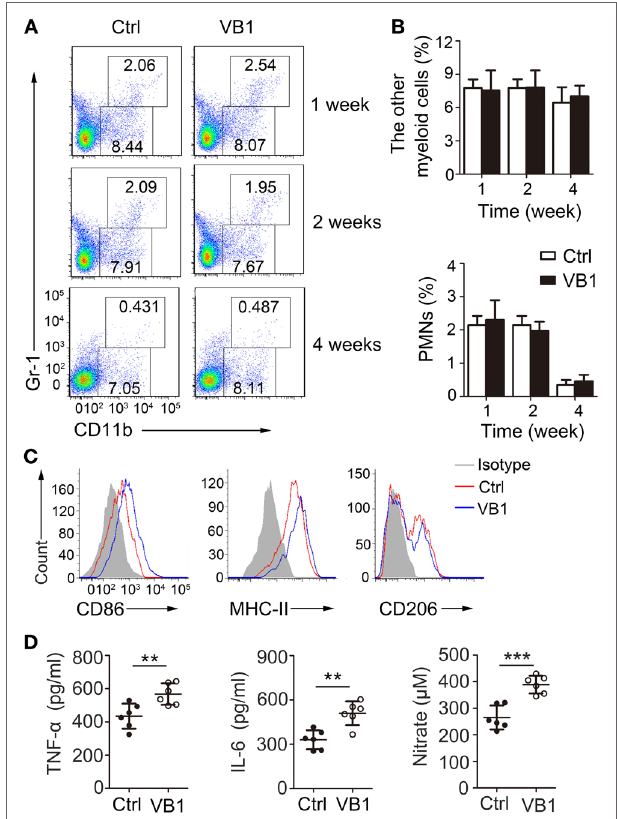
FigUre 2 | The pro-inflammatory effect of vitamin B1 (VB1) in lungs of Mycobacterium tuberculosis (MTB)-infected mice. Lung cells from H37Rv-infected mice treated with VB1 or untreated were harvested at 1 week, 2 weeks, and 4 weeks after infection. (a) The percentage of myeloid cells is displayed as dot plots. (B) The percentages of other myeloid cells and polymorphonuclear cells in lungs were shown. (c) The expressions of CD86, MHC-II, and CD206 were detected via flow cytometry at 4 weeks. (D) Concentration of tumor necrosis factor α (TNF- α ) and interleukin-6 (IL-6) in lungs (homogenized in 2 mL PBS and 0.05% Tween 80) from mice with MTB infection at 1 weeks were detected by enzyme-linked immunosorbent assay. Data shown are the mean ± SD. ** P < 0.01 and *** P < 0.001. Data are representative of three independent experiments with similar results.